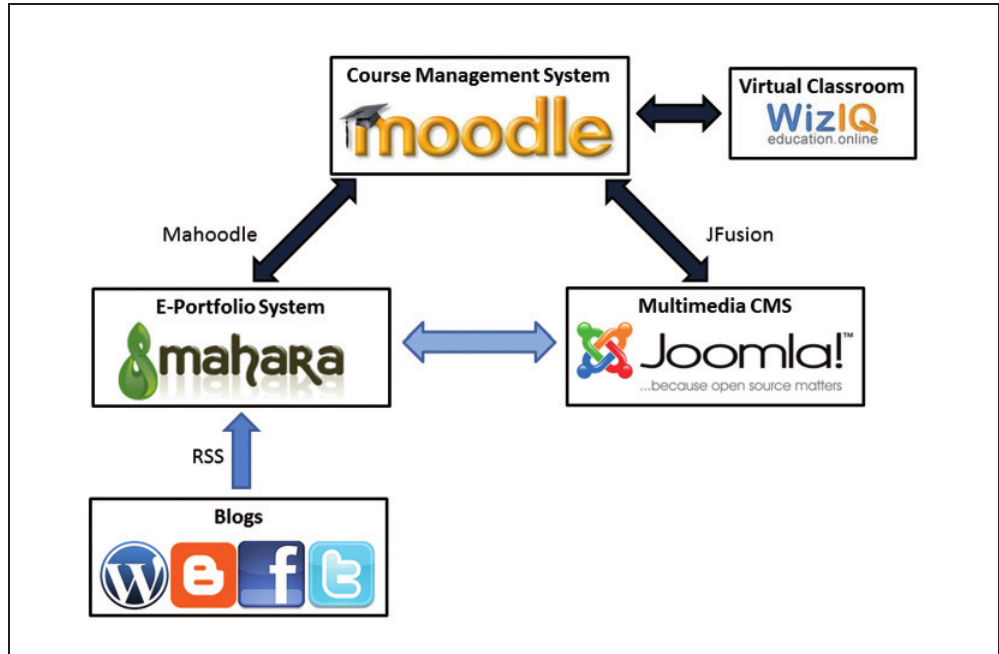
Figure 1 Moodle and other systems integrated to